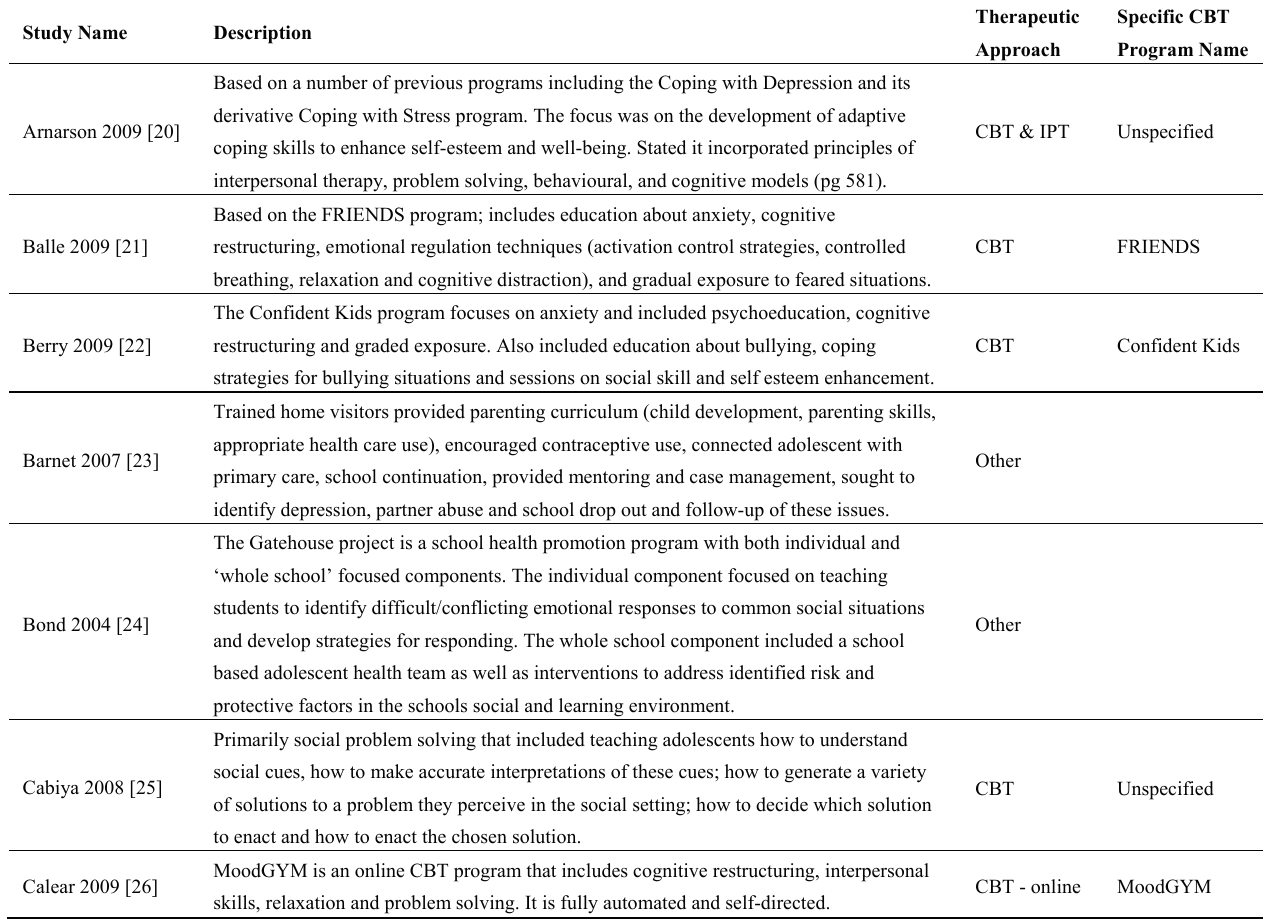
Table 1. Characteristics and coding of nature of interventions tested in included